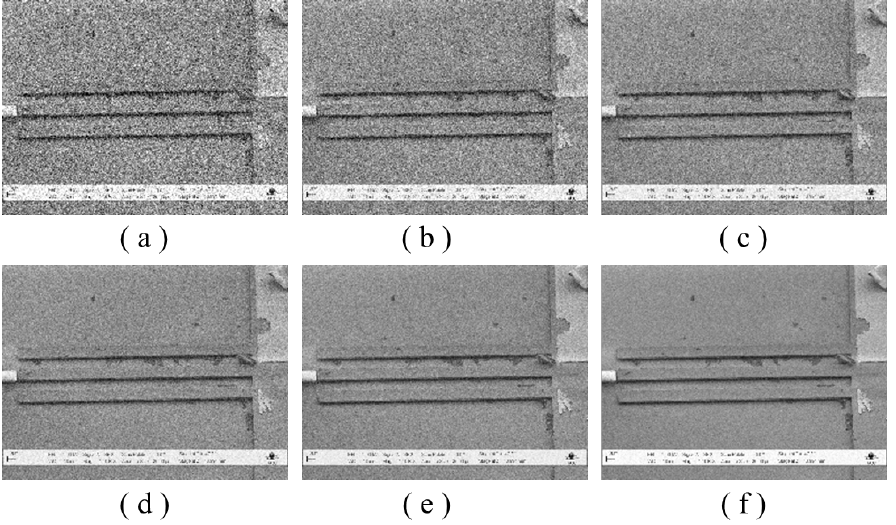
Figure 3. Effectiveness of noise averaging for heavy-noise images: ( a – e ) results of averaging 1, 2, 4, 8, and 16 LR images, and ( f ) clean LR image that is down-sampled from the HR